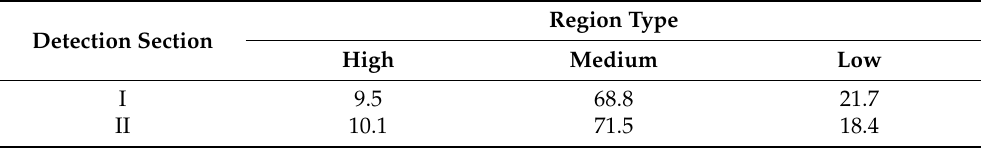
Table 4. Proportion of different density areas on detection section %.